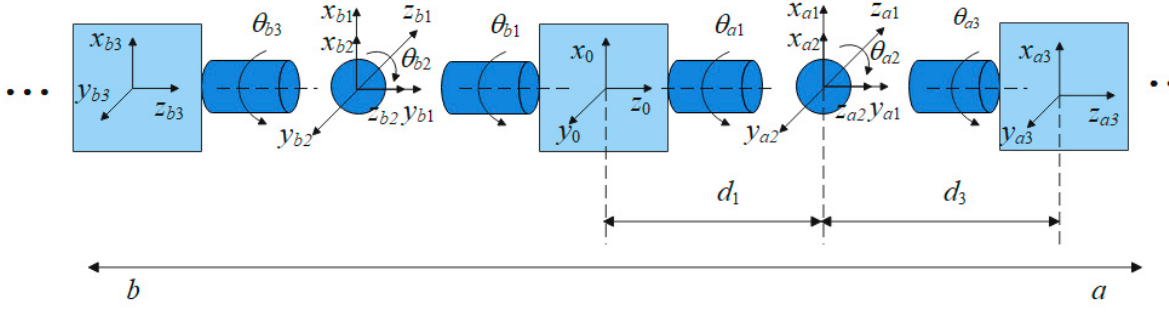
Figure 3. Linkage coordinate system for